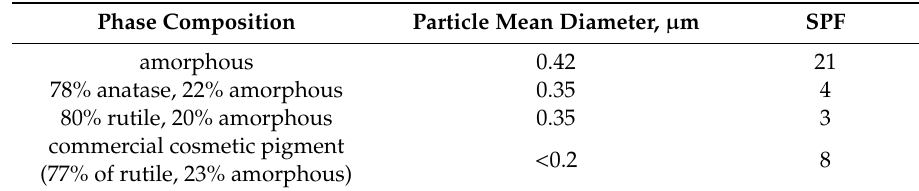
Table 3. SPF of titanium oxide amorphous, predominantly anatase, and predominantly rutile microspheres and commercial pigment.